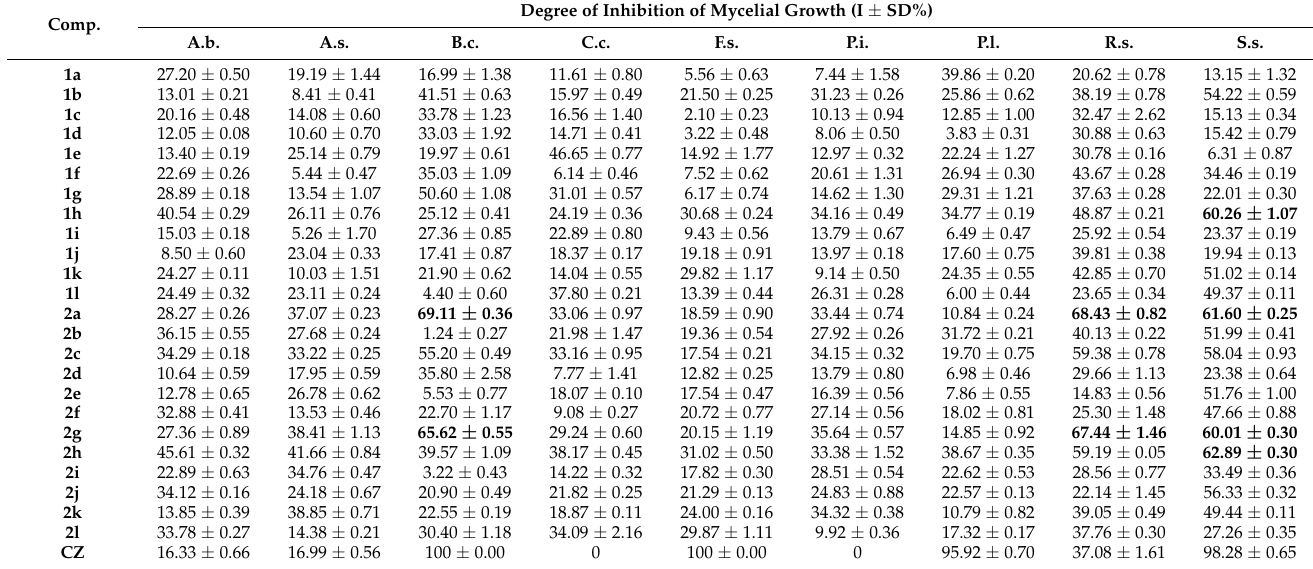
Table 3. Degree of fungal growth inhibition for compounds 1a – l and 2a – l at a concentration of 100 µg/mL (bold font indicates medium degrees of inhibition) *.